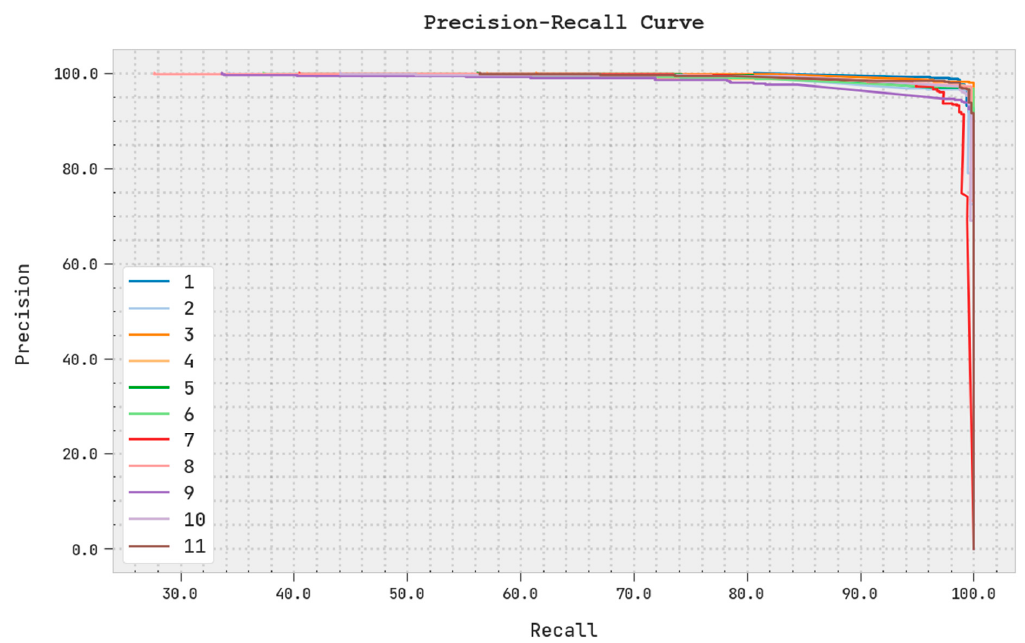
Figure 8. Precision–recall analysis of PODCNN-LWID approach.